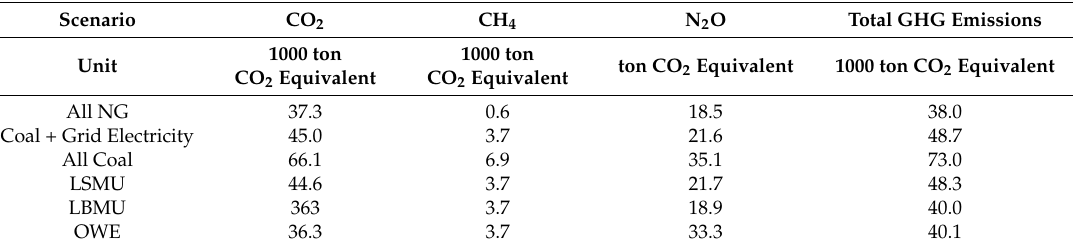
Table 9. Annual GHG emissions decomposition by gas type for the studied